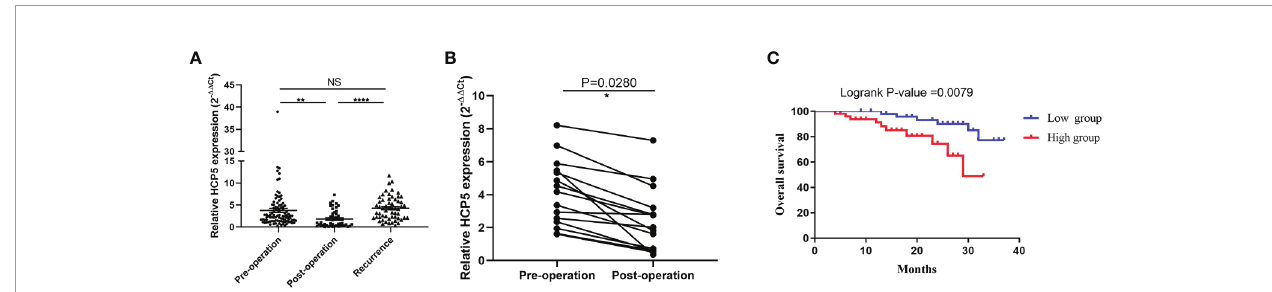
FIGURE 5 | Serum HCP5 in monitoring tumor dynamics in GC patients. (A) Detection of serum HCP5 expression in GC pre-operation patients (n=98), post- operation patients (n=46) and recurrence patients (n=57). (B) Altered expression of serum HCP5 in 15 paired samples preoperatively and postoperatively. (C) The survival curve of patients with GC. *P < 0.05, **P < 0.01, ****P < 0.001, NS means no statistically difference.